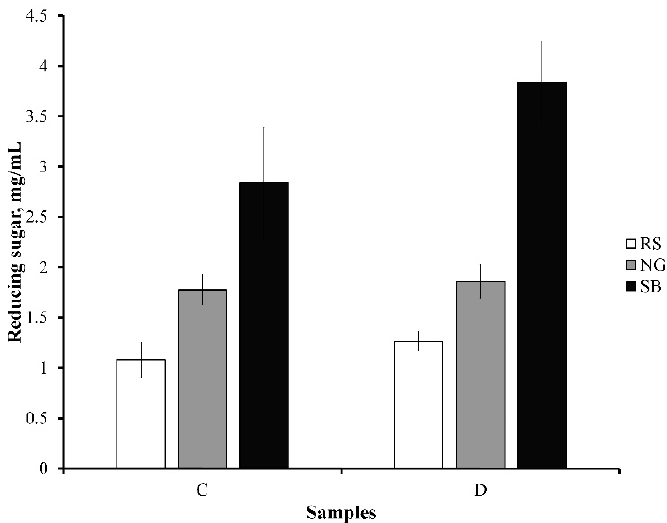
Figure 5. Enzymatic saccharification of control (C) and dewaxed (D) samples. RS—rice straw; NG—Napier grass; SB—sugarcane bagasse.